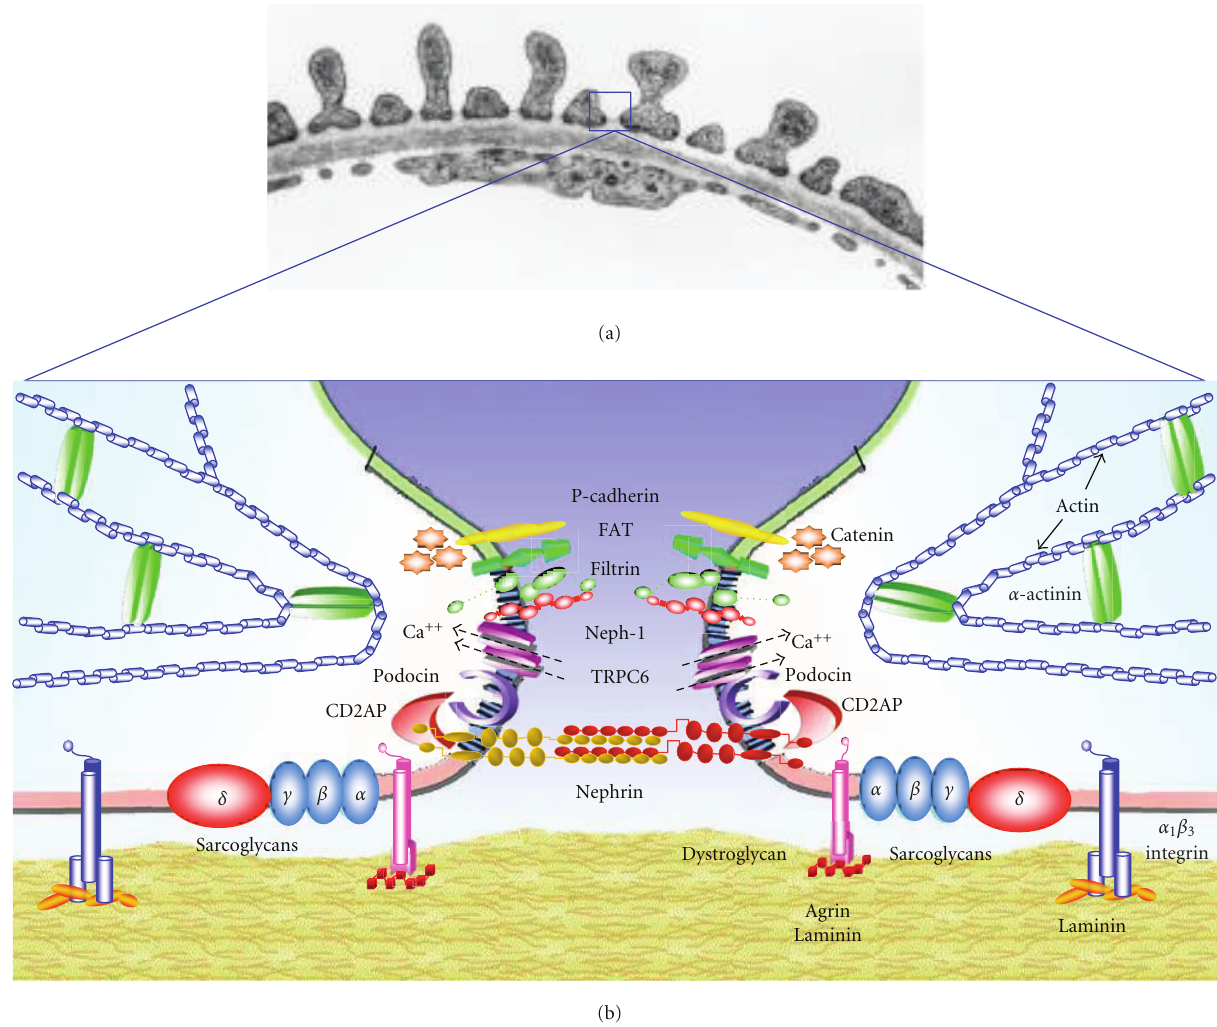
Figure 1: (a) Low-power view of glomerular filtration barrier in situ. The glomerular filter consists of three components: porous endothelium, glomerular basement membrane, and podocyte foot processes with the interposed slit membrane. Figure is transmission electron microscopy from a rat. Magnification: B , x ∼ 48,000. (b) Schematic drawing of the molecular equipment of the podocyte foot processes, similar to the area marked in Figure 1(a). See text for further explanations, (modified from